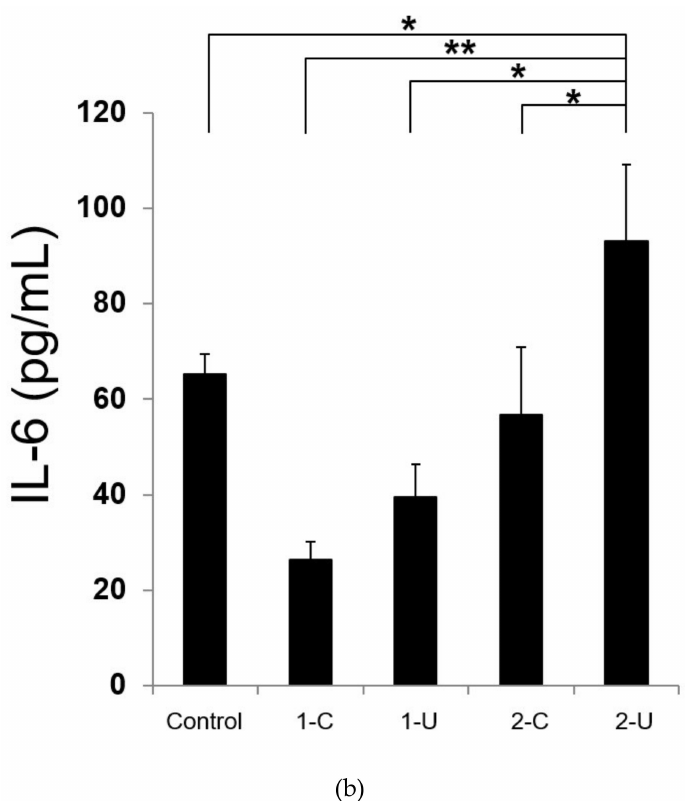
Figure 5. IL-6 levels in LX-2 cells. ( a ) IL-6 concentration in the supernatant of LX-2 cells. After treatment with TNF- α or nine bile acids (BAs), LX-2 cells were cultured for 48 h and the culture supernatant was collected. Supernatant levels of IL-6 were determined using an enzyme-linked immunosorbent assay. 1-C, primary conjugated BAs; 1-U, primary unconjugated BAs; 2-C, secondary conjugated BAs; 2-U, secondary unconjugated BAs. ( b ) IL-6 concentrations in the supernatant of LX-2 for BA classification. Data are expressed as the mean ± SD. Comparisons of different LX-2 cell treatments were carried out using one-way analysis of variance followed by Bonferroni’s correction (* p < 0.05; ** p <